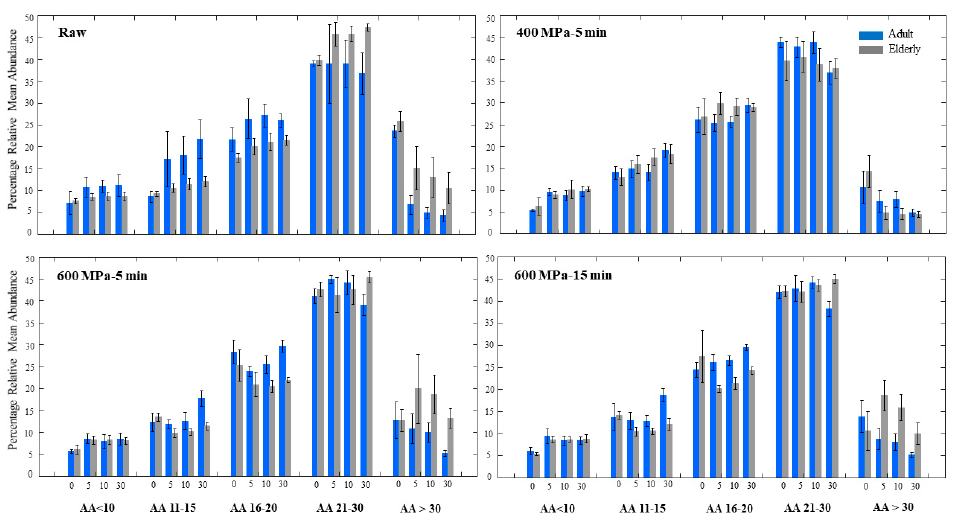
Figure 2. Relative mean abundance (%) of five groups of peptides categorized based on number of AA at 0, 5, 10 and 30 min gastric digestion of raw milk and HPP treated milks using in vitro adult and elderly models. The bars are the average of two independent replicates and the error bars represent the standard deviations.